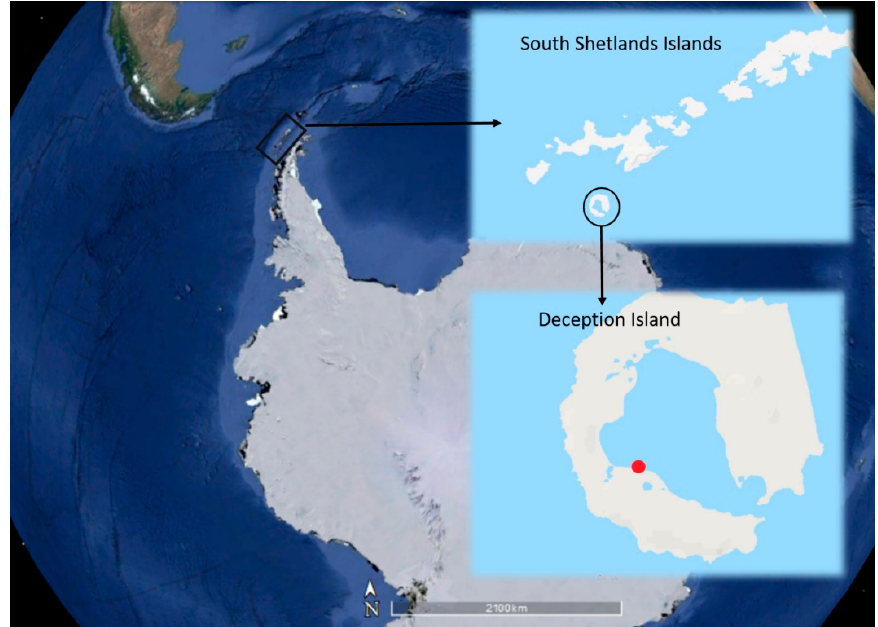
Figure 1. Map of Deception Island with the location of Gabriel de Castilla Spanish Antarctic Research Station. The red circle point indicates the position of the research base.